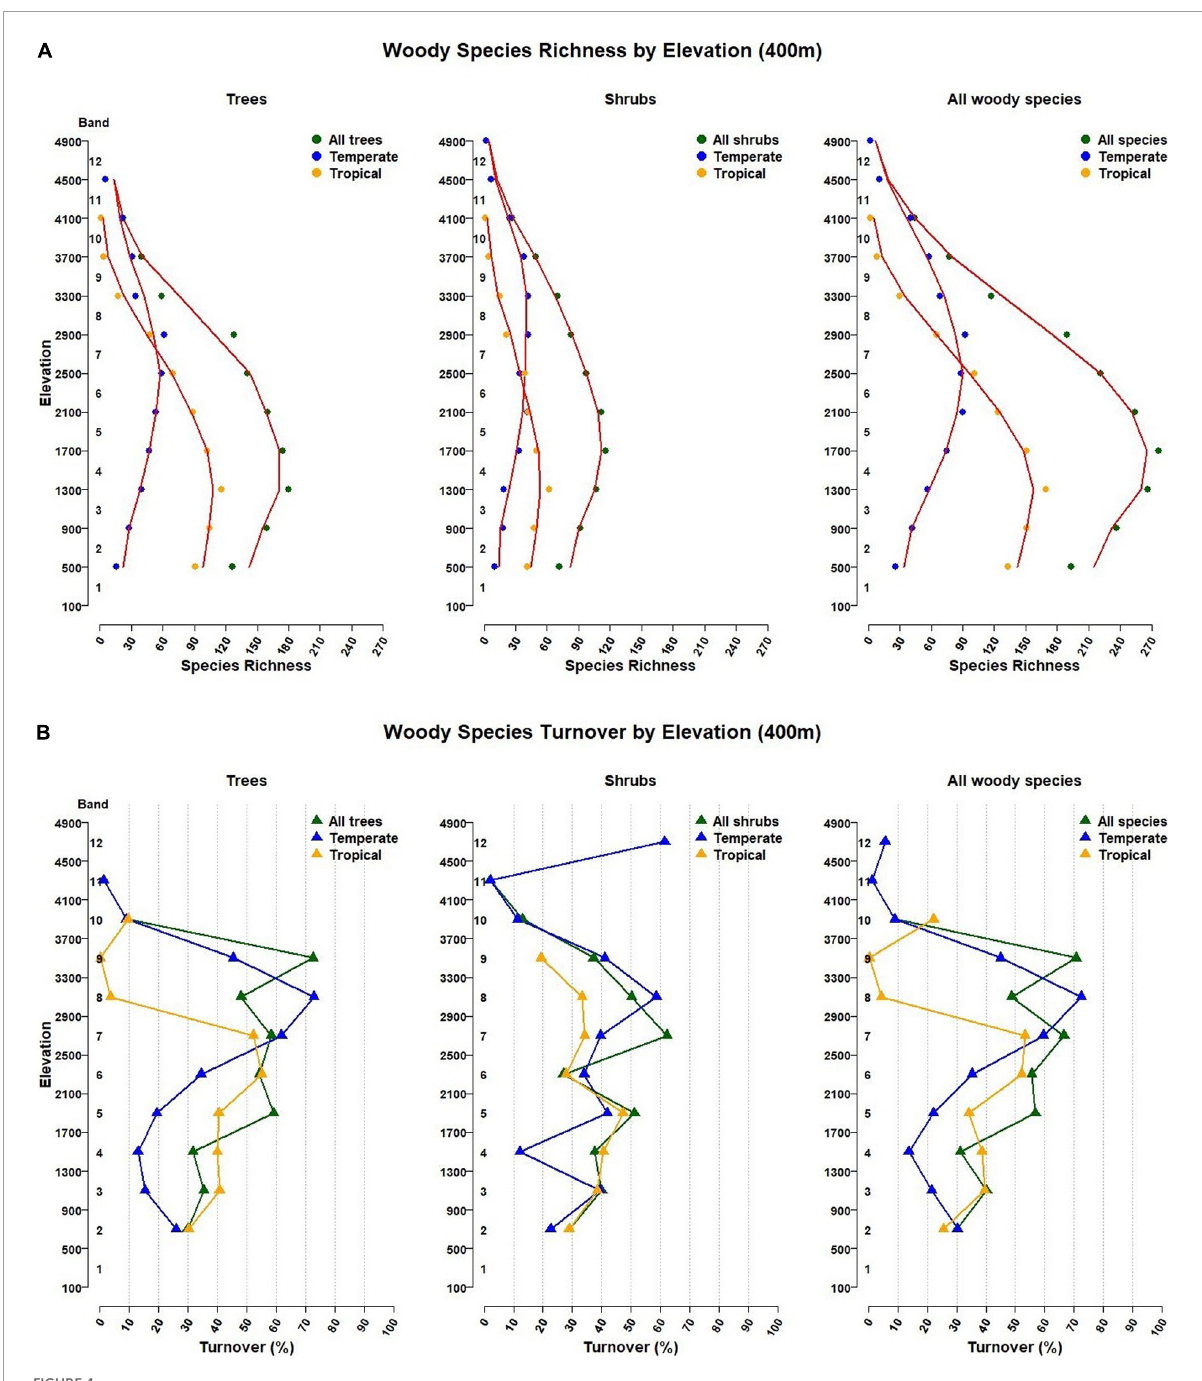
FIGURE4 (A) Woody species richness patterns and (B) Woody species turnover by elevation band in Bhutan. Elevations are presented in twelve 400 m elevation bands starting at 100 m. In (A), the red lines are a moving average from three elevation bands. In (B), turnover percentages shown are from the band below to the band the triangle is in. Corresponding elevation band values are in Table 2 .